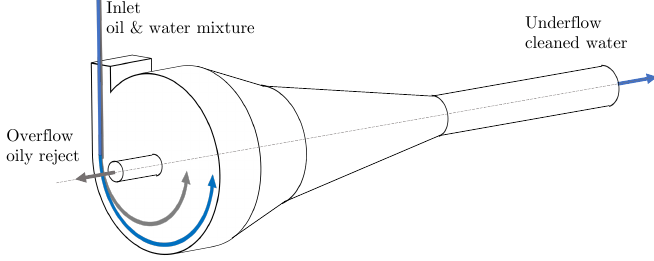
Figure 2. Separation principle of a deoiling